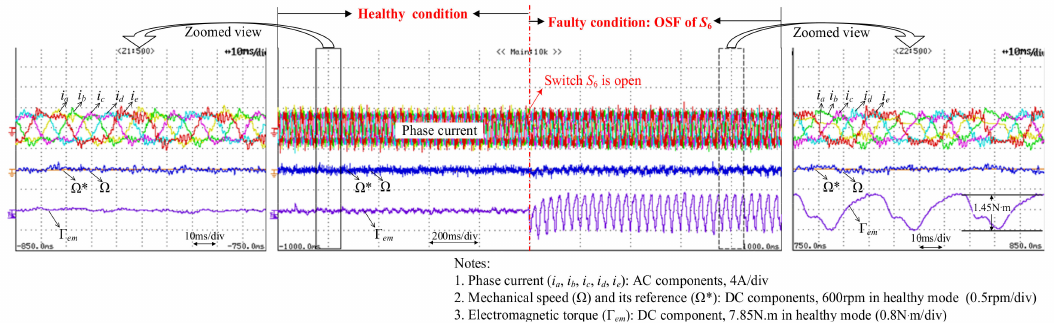
Figure 11. Experimental test with OSF occurrence of S 6 without the proposed AFTC strategy.